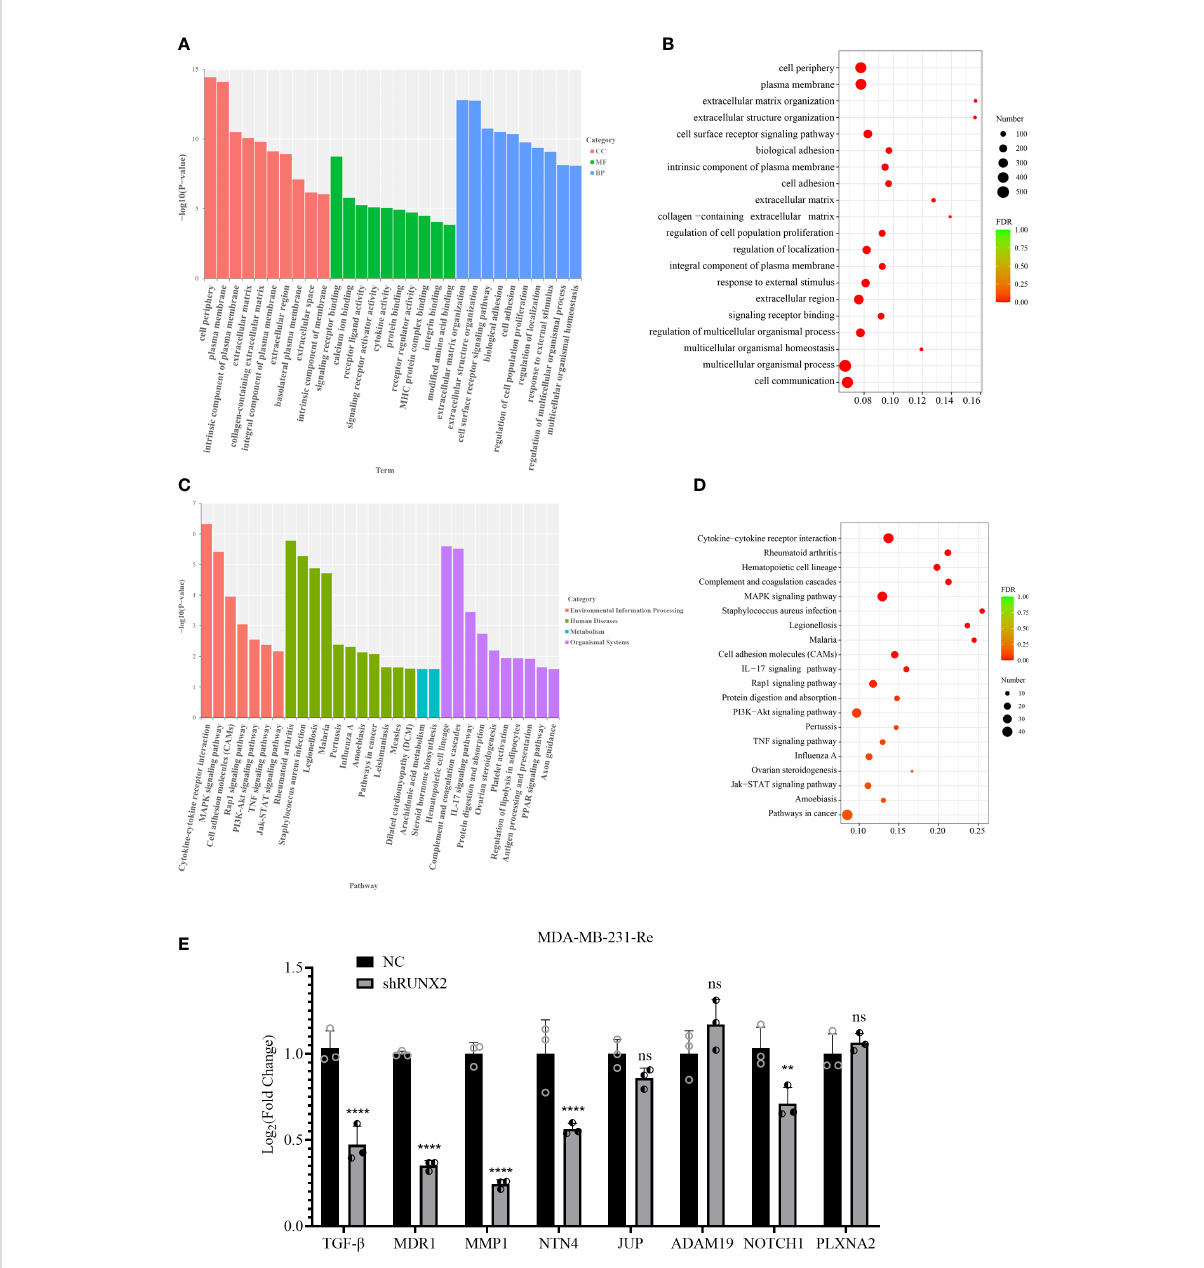
FIGURE 6 Function and signal prediction of the DEGs in TNBC. (A, B) Bar chart of the top 10 GO terms (A) and bubble plots of the top 20 GO terms (B) in each GO classi fi cation based on the enriched DEGs. (C, D) Bar chart (C) and bubble diagram (D) of the top 20 KEGG pathways based on the enriched DEGs. (E) qRT-PCR analysis of candidate gene expression in MDA-MB-231-Re cells in shRUNX2 and NC MDA-MB-231-Re cells. All data were shown as mean ± SD (N=3 independent samples). **P<0.01; ****P<0.0001; ns, not signi fi